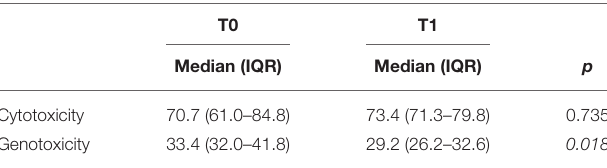
TABLE 3 | Cytotoxicity (expressed as a percentage of viable cells) and genotoxicity (expressed as % of DNA in the tail) of fecal water before (T0) and after 1 month (T1) of the